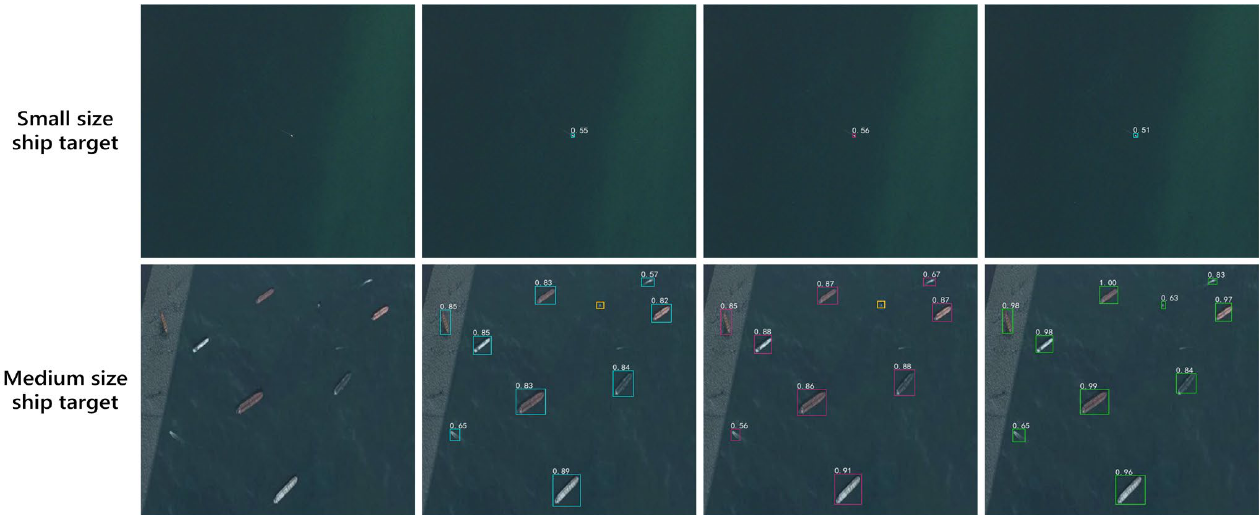
Figure 17. Visualization results of the best three methods. Note that the above six cases are shown in the figure, including small-sized ships, medium-sized ships, multi-target aggregation, sea clutter, wake waves, and cloud interference. In marine ship detection, the actual scene often contains a com- bination of the above six situations under different illumination levels. Part of the images in the figure is also the result of various combinations. For example, the fourth row includes both wake